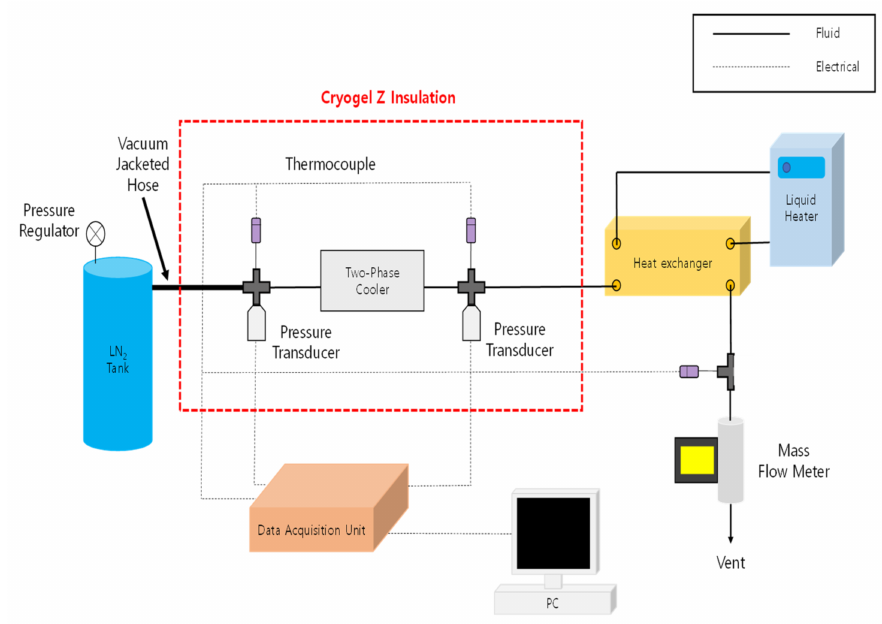
Figure 3. Schematic of a test rig to investigate the performance of cryogenic microcoolers with LN 2